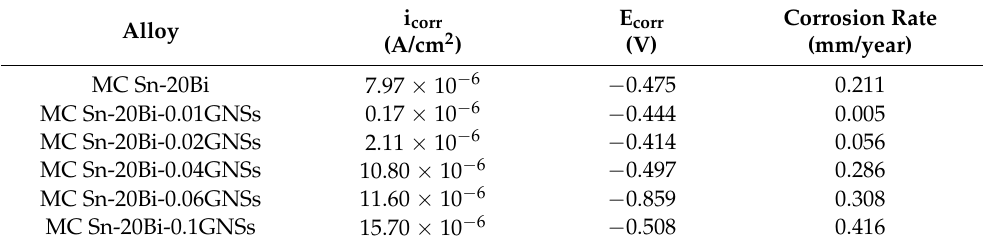
Table 2. Electrochemical corrosion parameters of MC Sn-20Bi- q GNSs alloys in 3.5 wt.% NaCl